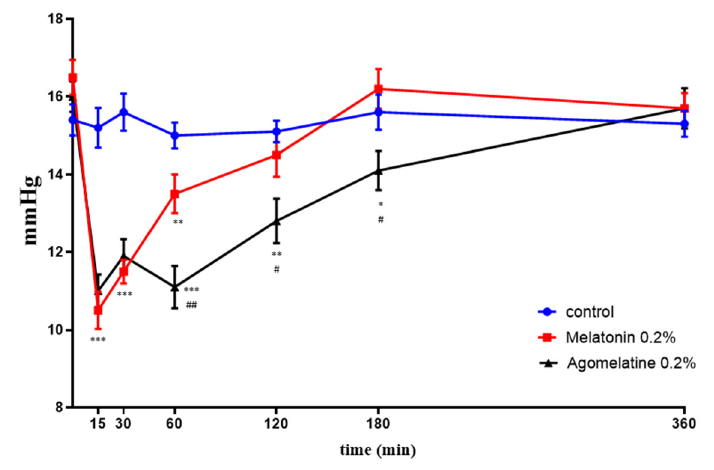
Figure 12. Time-course of the hypotonizing effects of melatonin 0.2% vs. agomelatine 0.2% in normotensive rats. *** p < 0.001, ** p < 0.01, * p < 0.05 vs. control; ## p < 0.01, # p < 0.05 vs. melatonin.